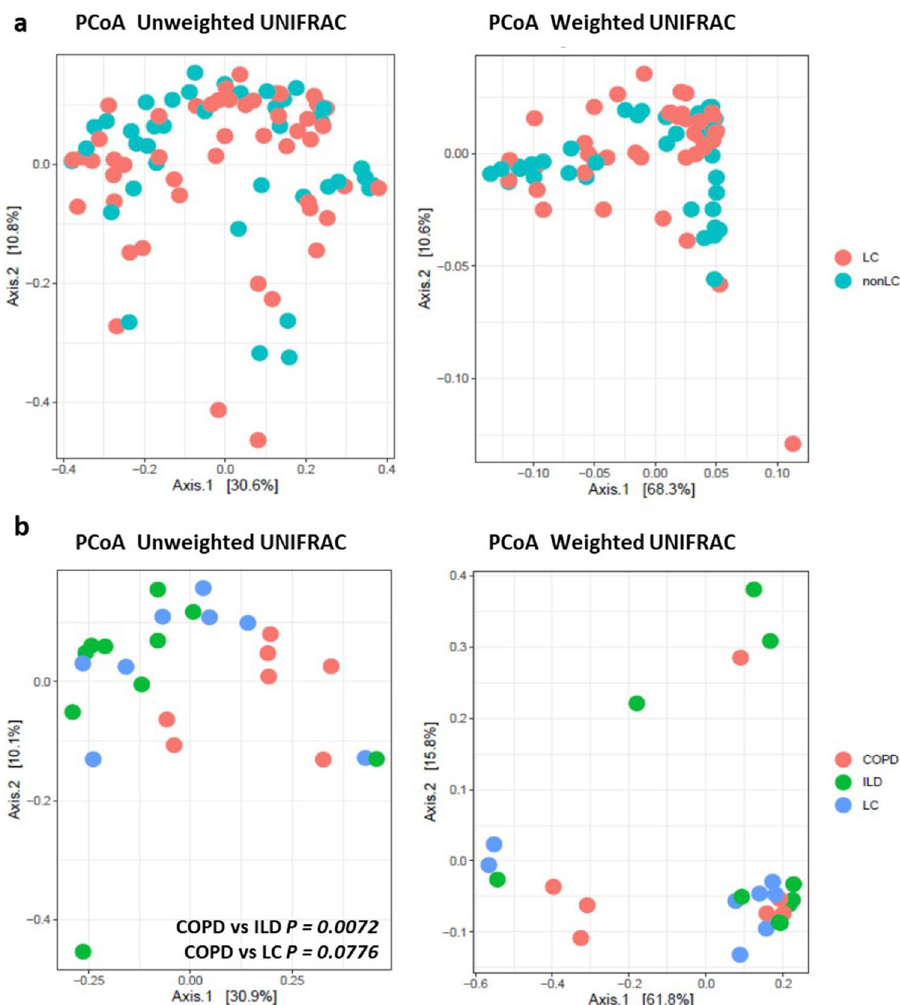
Figure 3. Beta diversity as shown by principle coordinate analysis of unweighted UniFrac distances and weighted UniFrac distances. ( a ) Extended dataset comprising LC (N = 49) and non-LC groups (N = 40); ( b ) Comorbidity controlled dataset including COPD (N = 7), ILD (N = 10) and LC* (N = 8)